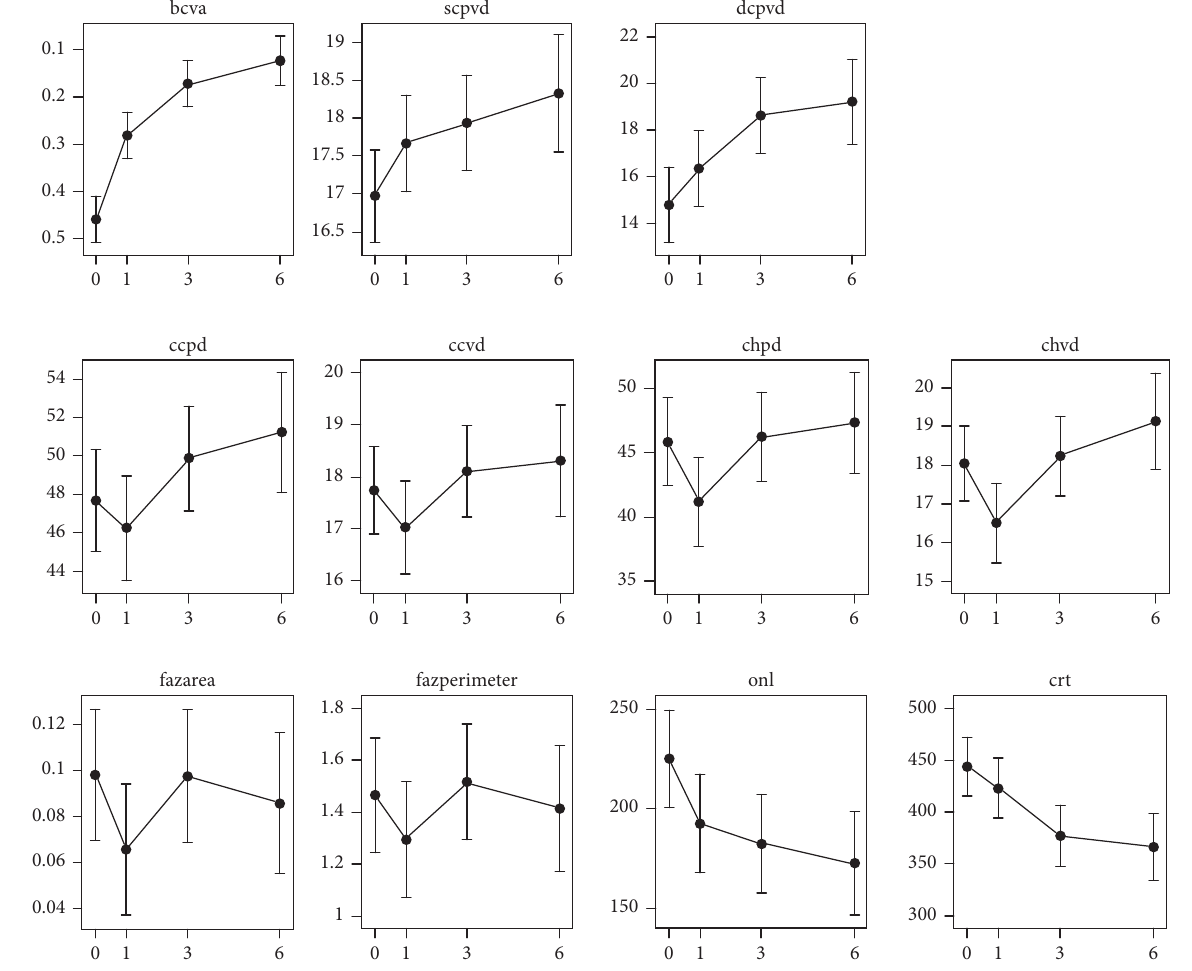
Figure 3: Progression graphs. On the abscissa, the time expressed in months is